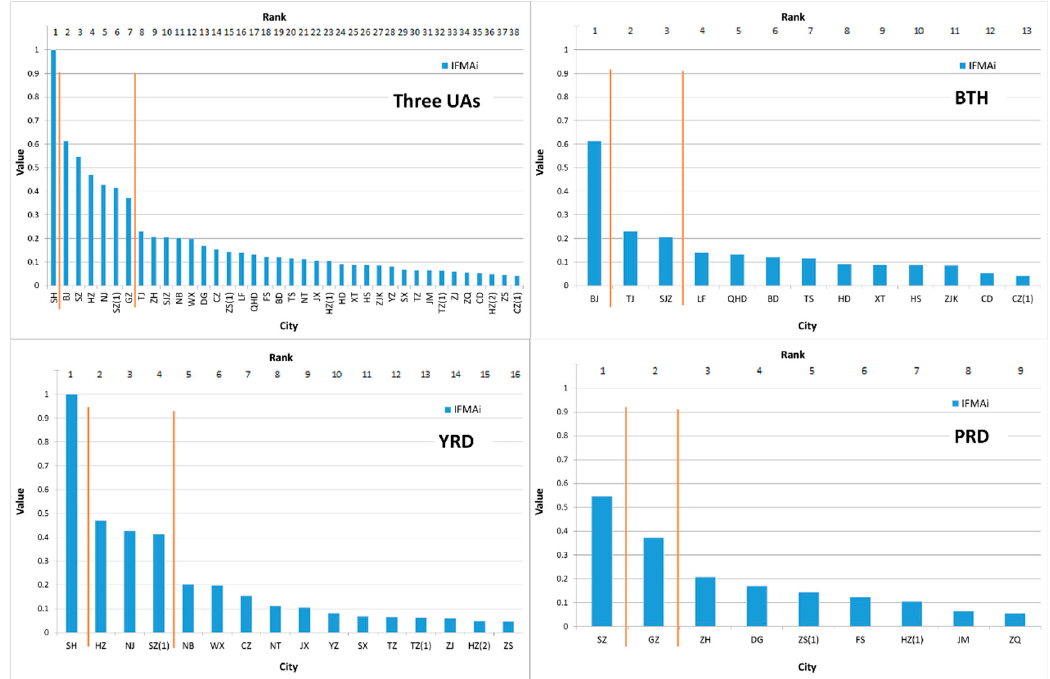
Figure 4. Rank and size of IFMA i . SH: Shanghai, BJ: Beijing, SZ: Shenzhen, HZ: Hangzhou, NJ: